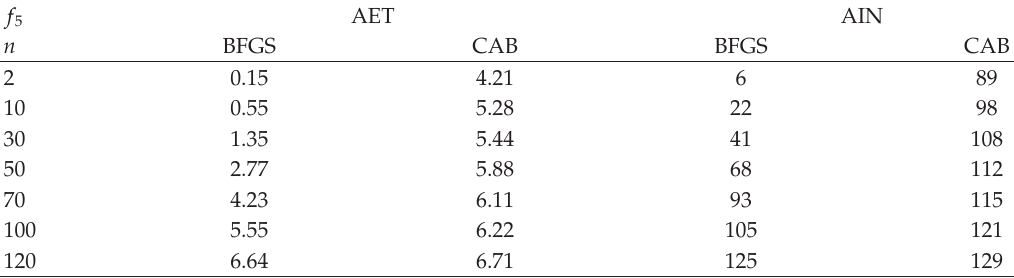
Table 10: Performance comparison between the BFGS and the CAB algorithm, considering di ff erent dimensions over the Rosenbrock function. The averaged elapsed time (cid:2) AET (cid:3) is referred in seconds. f 5 AET